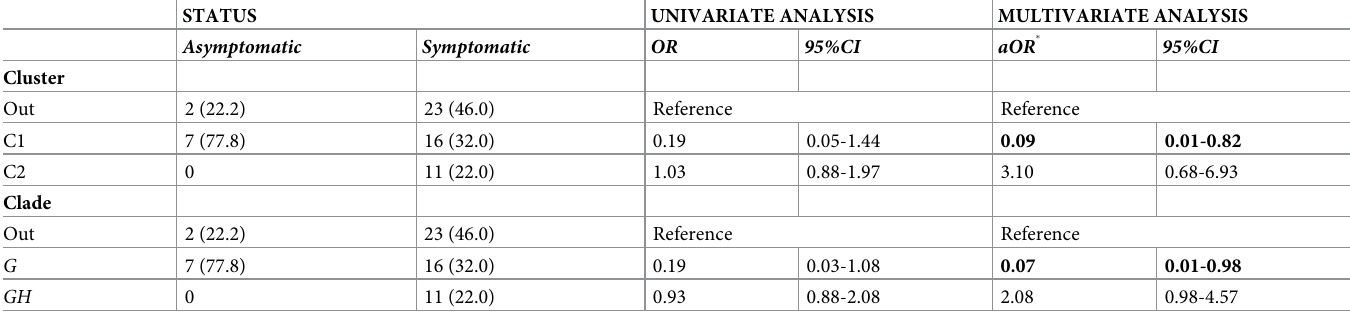
Table 3. Ordinal logistic regression model to assess the association between clusters, GISAID clade and patient status. C1 (N = 23); C2 (N = 11); Out, represent the remaining Amazonas genomes (N = 25).